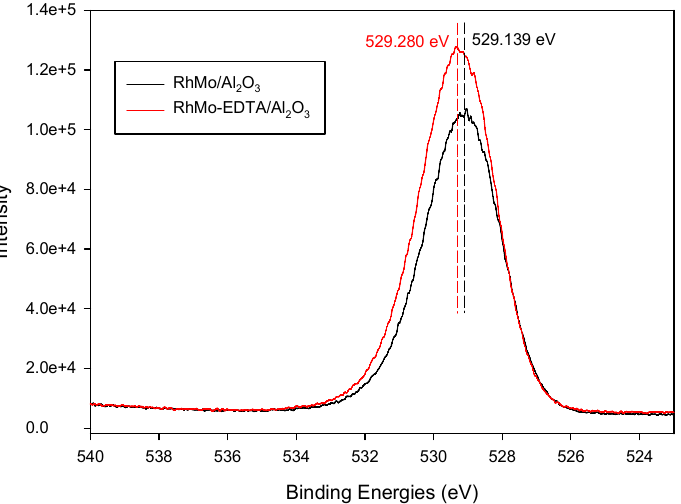
Figure 9. XPS spectra of O 1s of RhMo/ ɣ -Al 2 O 3 and RhMo-EDTA/ ɣ -Al 2 O 3 .